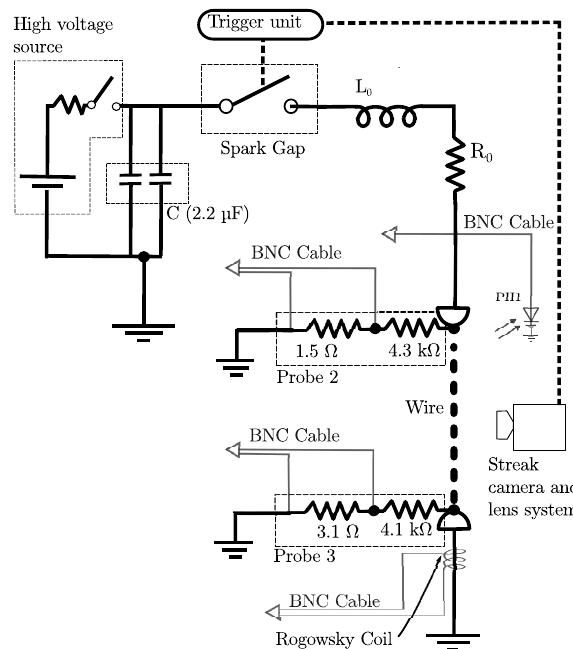
Figure 1. Exploding wire setup. PH1 signals the photodiode, C the capacitors bank, and L 0 and R 0 the lumped inductance and resistance of the setup, respectively.